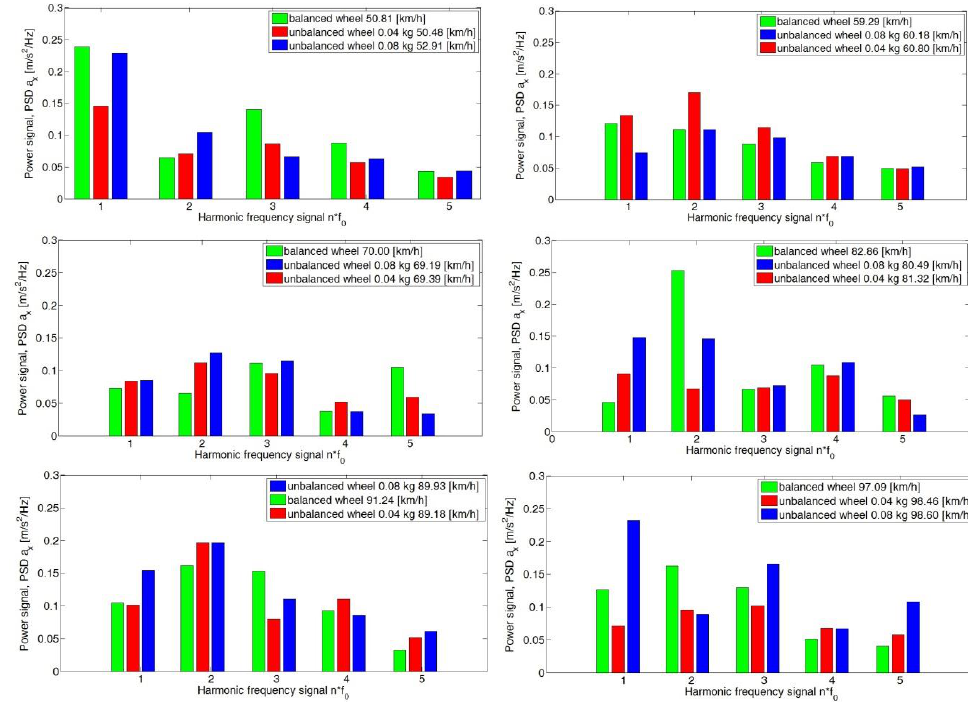
Figure 10. Signal power values of the analyzed harmonics of the x -axis for the adopted speed ranges for the road test.